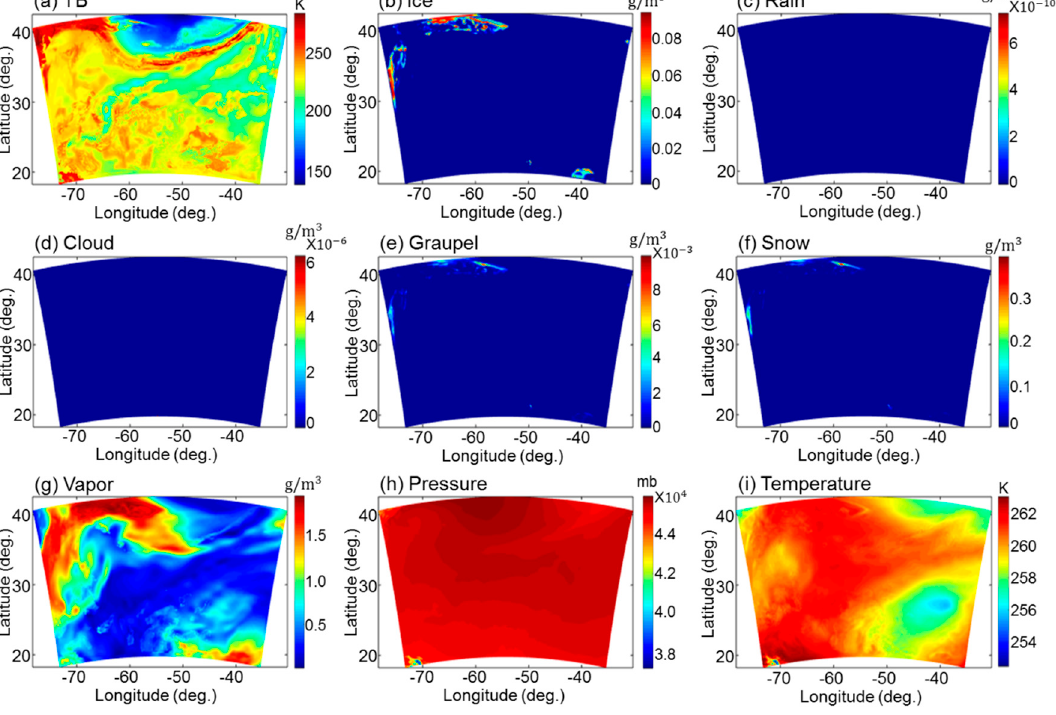
Figure 8. Simulated brightness temperature at 89 GHz, and corresponding atmospheric thermodynamic and hydrometeor state vectors at 460 mb.